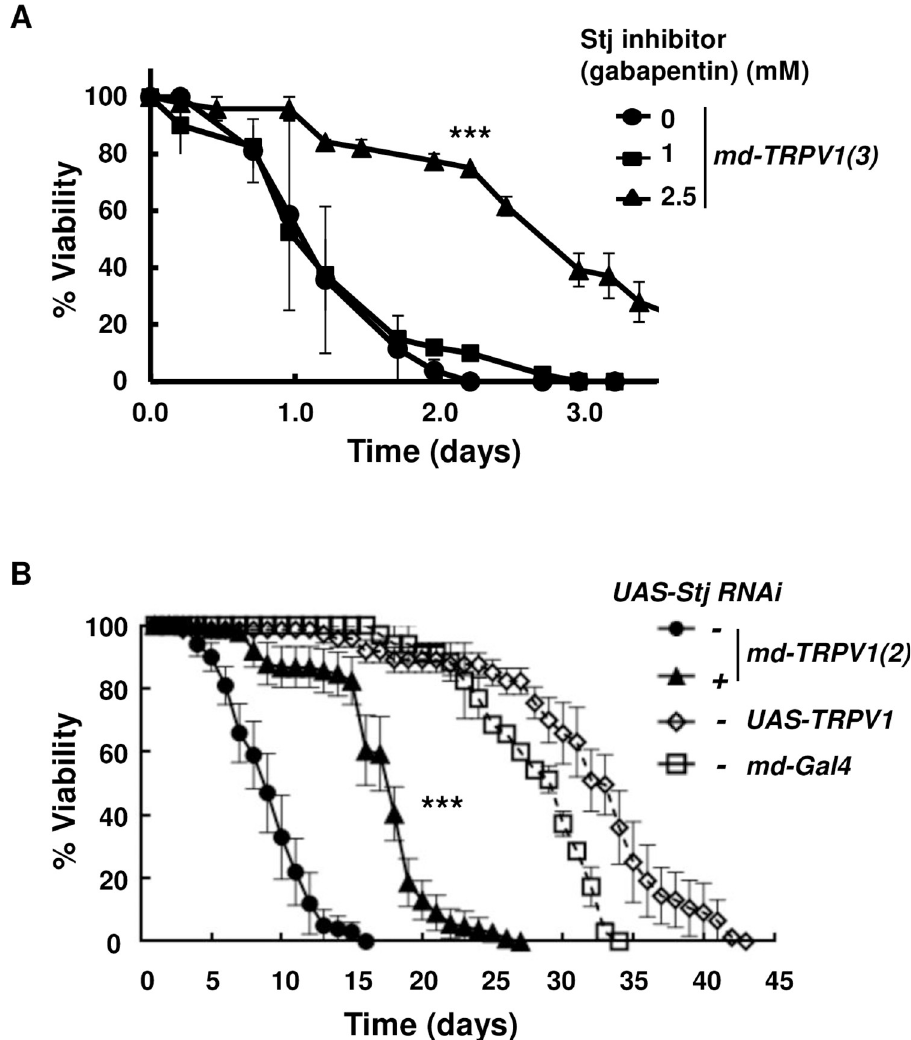
Fig 3. Effect of gabapentin and its target, sti , the α 2 δ -subunit of voltage-gated calcium channels, on the viability of md-TRPV1 flies grown on capsaicin-containing food at 29˚C. (A) Viability of md-TRPV1(3) flies reared on food that contained capsaicin (5 mM) and gabapentin at the concentrations indicated. Dots and vertical lines denote means and standard deviations, respectively. n = 60 for each curve; one-way ANOVA with the Tukey-Kramer method for multiple comparisons, ��� P < 0.001 for no gabapentin vs 2.5 mM gabapentin. md-TRPV1(3) denotes one copy of md-Gal4 and 3 copies of UAS-TRPV1 . (B) Viability of md-TRPV1(2) flies bearing one copy of md-Gal4 and two copies of UAS-TRPV1 with or without UAS-stj RNAi grown on food with capsaicin (5 mM) at 29˚C. Other flies ( UAS-TRPV1 and md-Gal4 ) were used as controls. Dots and vertical lines denote means and standard deviations, respectively. n = 60 for each curve; one-way ANOVA with the Tukey-Kramer method for multiple comparisons, ��� P < 0.001 for md- TRPV1(2) vs md-TRPV1(2) , UAS-stj-RNAi , in which (2) indicates two copies of UAS-TRPV1 . All flies were 5-day-old males. Reducing copy number from three to two increased viability four-fold; reducing further to one copy increased viability eleven-fold (Fig 2D). These confirm the notion that capsaicin-associ- ated viability in transgenic md-TRPV1 flies is dependent on the magnitude of TRPV1 activa- tion and thus the degree of nociceptor activation and total nociception.